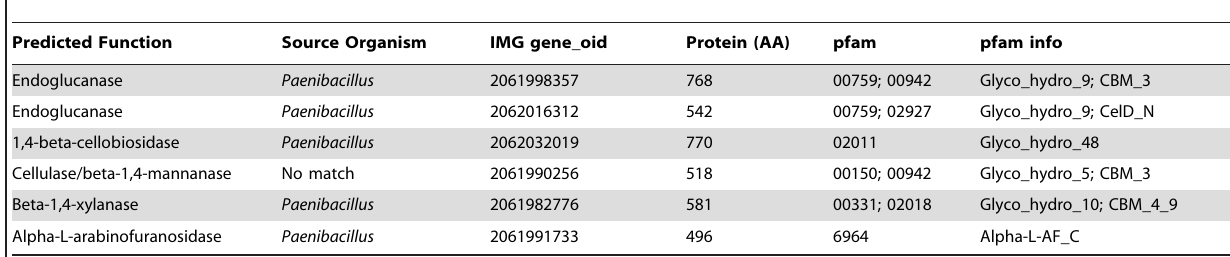
Table 2. Cellulase and xylanase from the thermophilic community identified by proteomics.